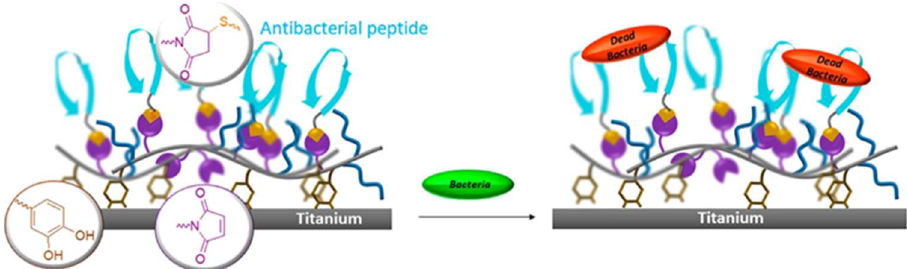
Figure 2. Schematic of antimicrobial peptides causing bacterial cell death. Reprinted with permis- sion from Ref. [62] Copyright 2019 American Chemical Society.